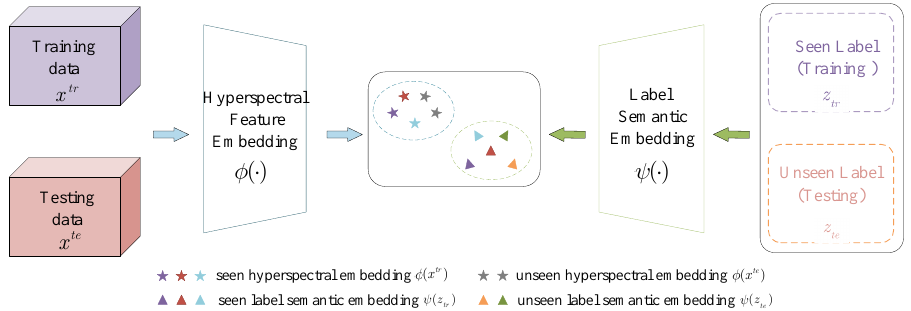
Figure 5. Illustration of phase A, feature embedding, embed hyperspectral features and label semantic features into the corresponding feature spaces, respectively. Stars and triangles in the same color belong to the same category, and the gray one represents the unseen